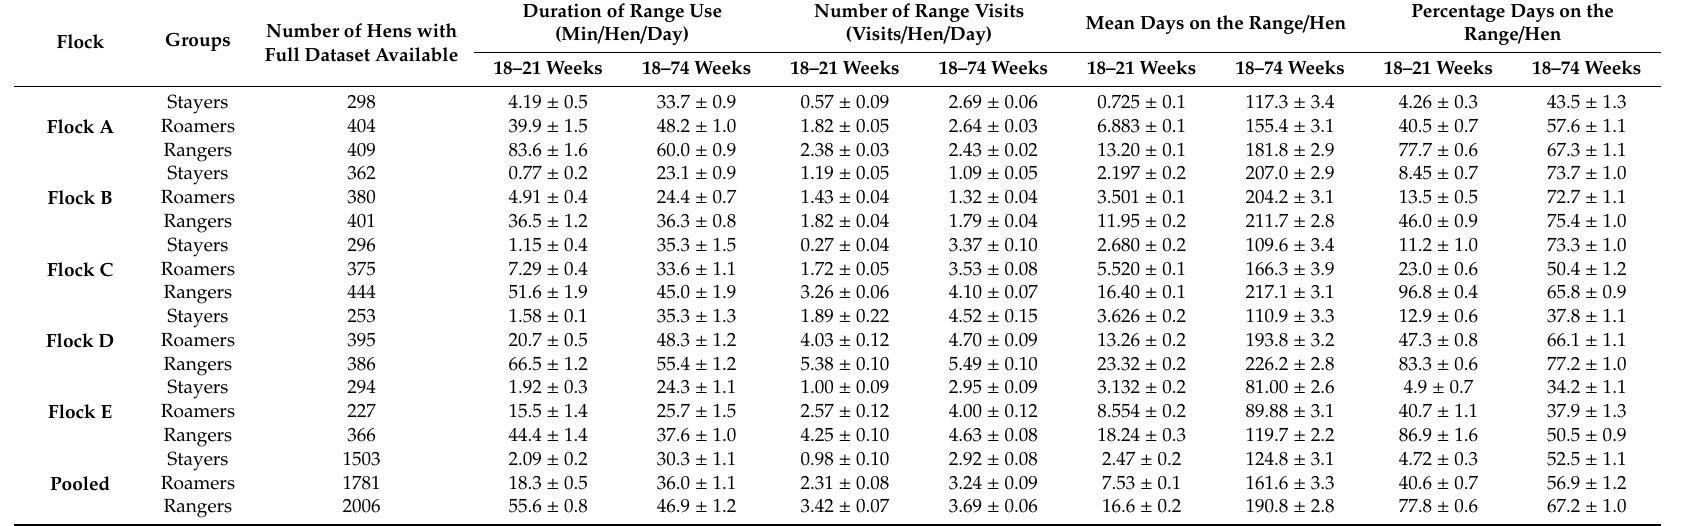
Table 1. Mean ( ± SEM) duration of range use, number of visits, number of days on the range during early life (18–21 weeks) and whole life (18–72 weeks) of the stayers, roamers and